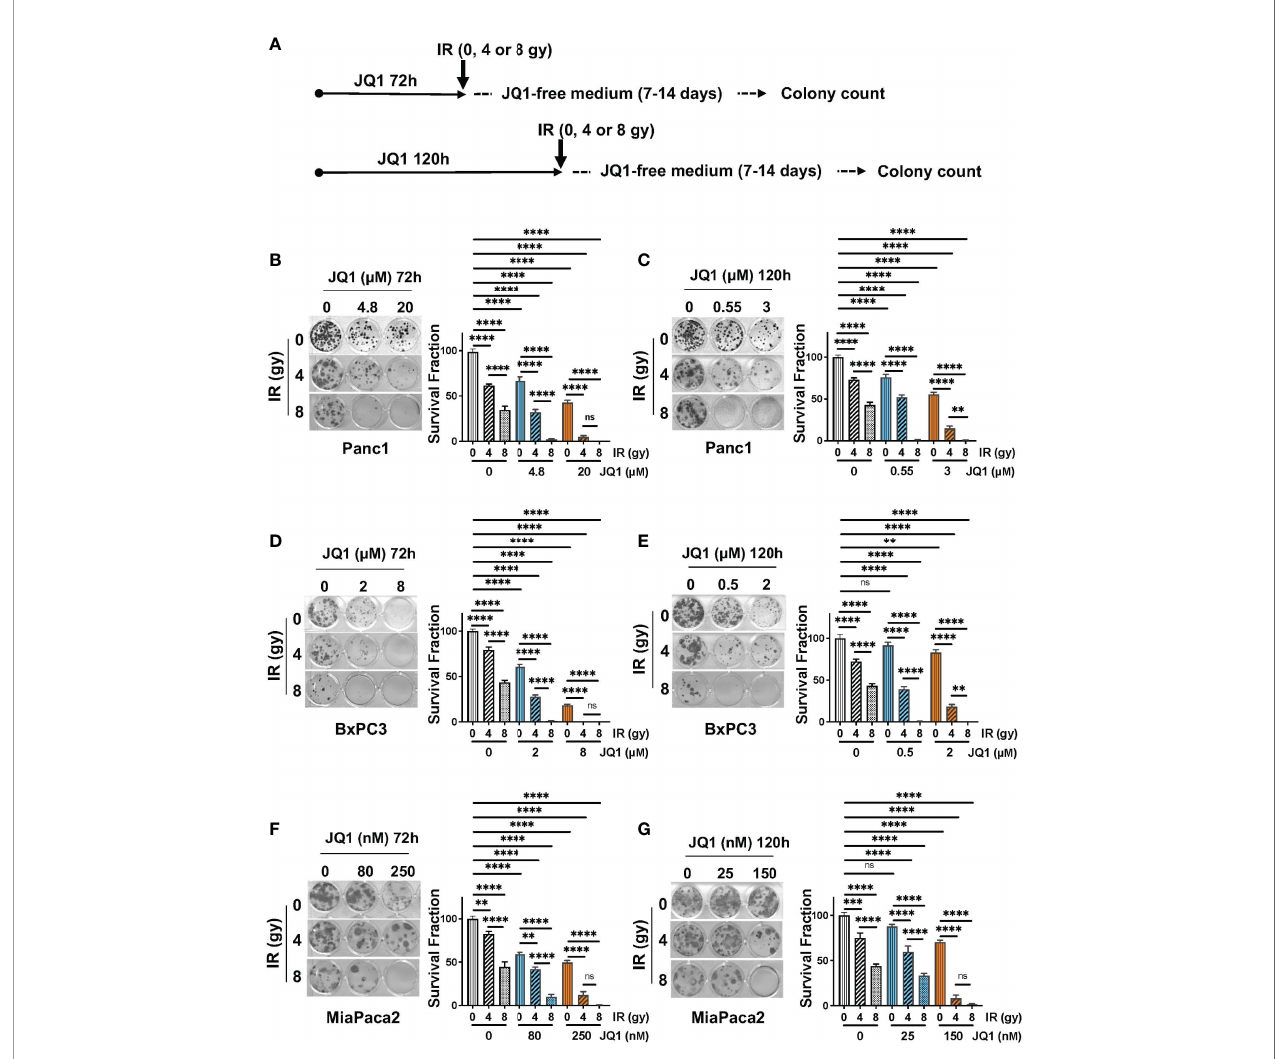
FIGURE 1 | The combination of JQ1 + IR reduces clonogenic potential more than JQ1 or IR as a single modality. (A) Schematic of the clonogenic assay protocol. Cells were exposed to JQ1 for 72h and 120h. (B, C) Images of representative plates showing colonies produced by Panc1 cells at (B) 72 hours or (C) 120 hours exposure to JQ1 ± IR. (D, E) Images of representative plates showing colonies (left panel) and survival fraction (right panel) of BxPC3 cells at (D) 72 hours or (E) 120 hours after treatment. (F, G) Images of representative plates showing colonies (left panel) and survival fraction (right panel) of MiaPaCa2 cells at (F) 72 hours or (G) 120 hours after treatment. Data are reported as average survival fraction ± SEM, as shown on bar graphs to the right of each plate image. One-way ANOVA followed by Tukey multi comparison analysis was performed as described in Materials and Methods. **p < 0.01, ***p < 0.001, ****p < 0.0001. ns, not signi fi